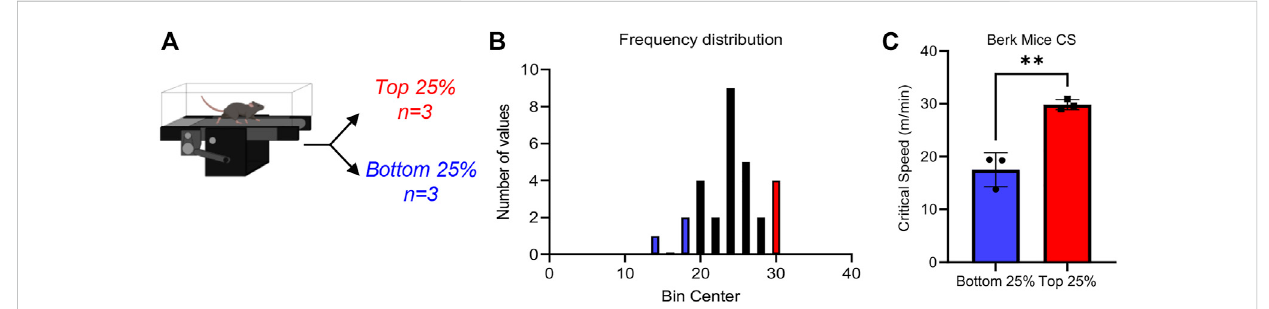
FIGURE 1 Critical speed overview Sickle Cell mice underwent critical speed test, then were separated into Top 25% ( n = 3) and Bottom 25% [ n = 3 — (A) ]. In (B) , frequency distribution of mouse critical speed. Blue represents Bottom 25% and red represents Top 25% ( n = 3) selected for the study. In (C) , top